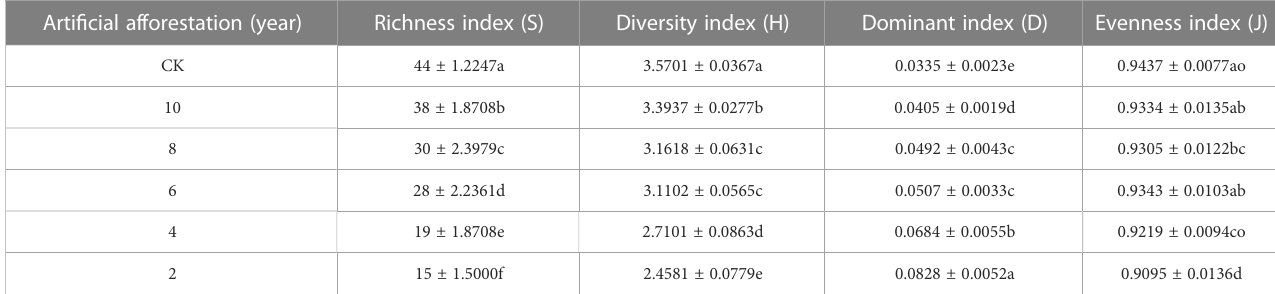
TABLE 3 a -Diversity index of grassland plant communities with different arti fi cial afforestation years in Maxian Mountain of the Loess Plateau. Arti fi cial afforestation